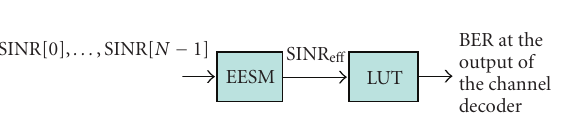
Figure 10: BER prediction through